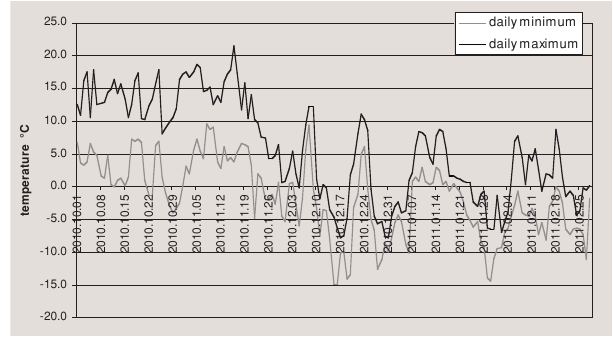
Figure 1. Daily minimum and maximum temperatures at Pallag between 2010 October 1 and 2011 February 28 ( Debrecen–Pallag,